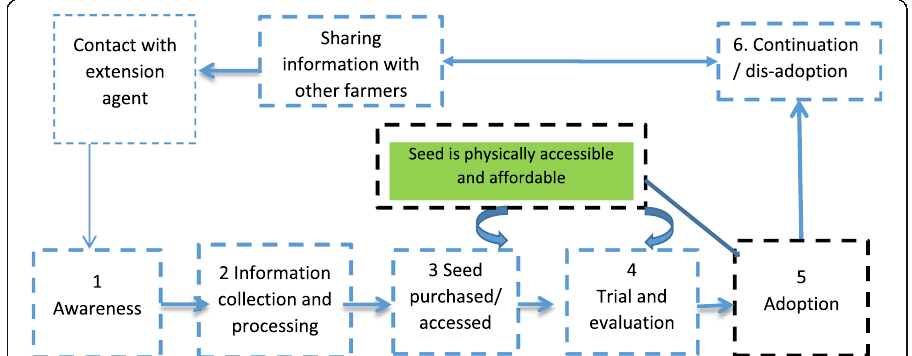
Fig. 2 Stages of the adoption process for improved